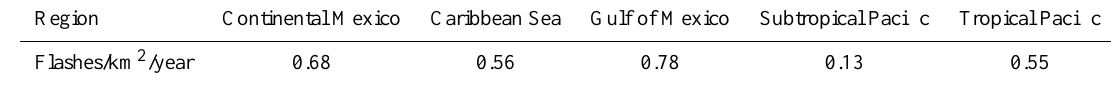
Table 1. Average number of flashes per km 2 per year detected by the WWLLN for each region considered in this study.